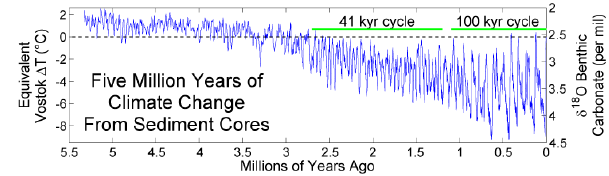
Fig. 2. Thermal history of the last 5.5 mln years of surface forcing (modified from [20]).